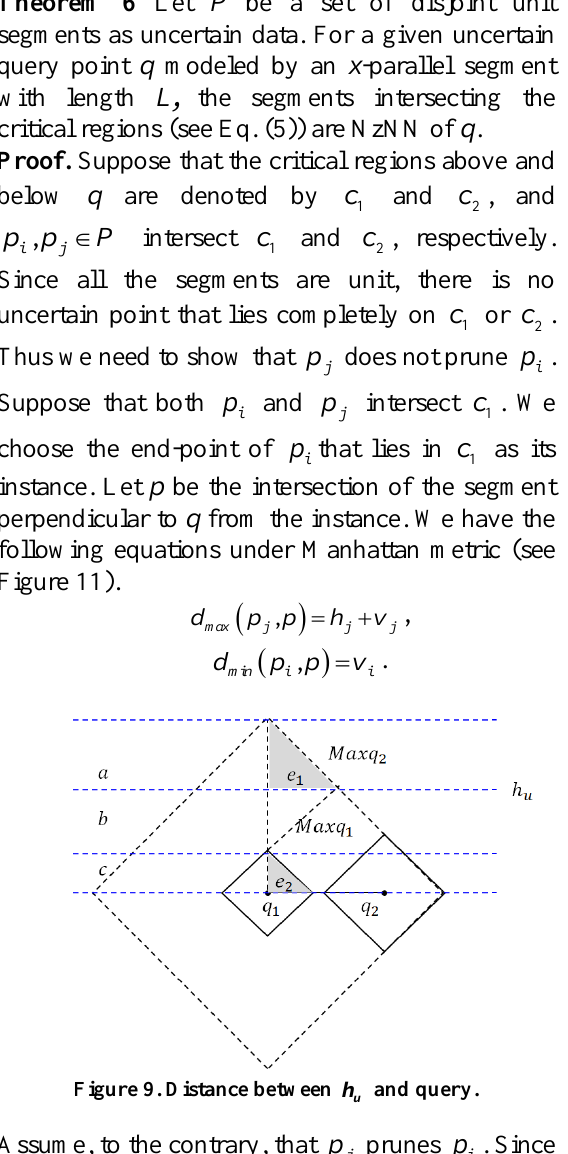
Figure 9. Distance between